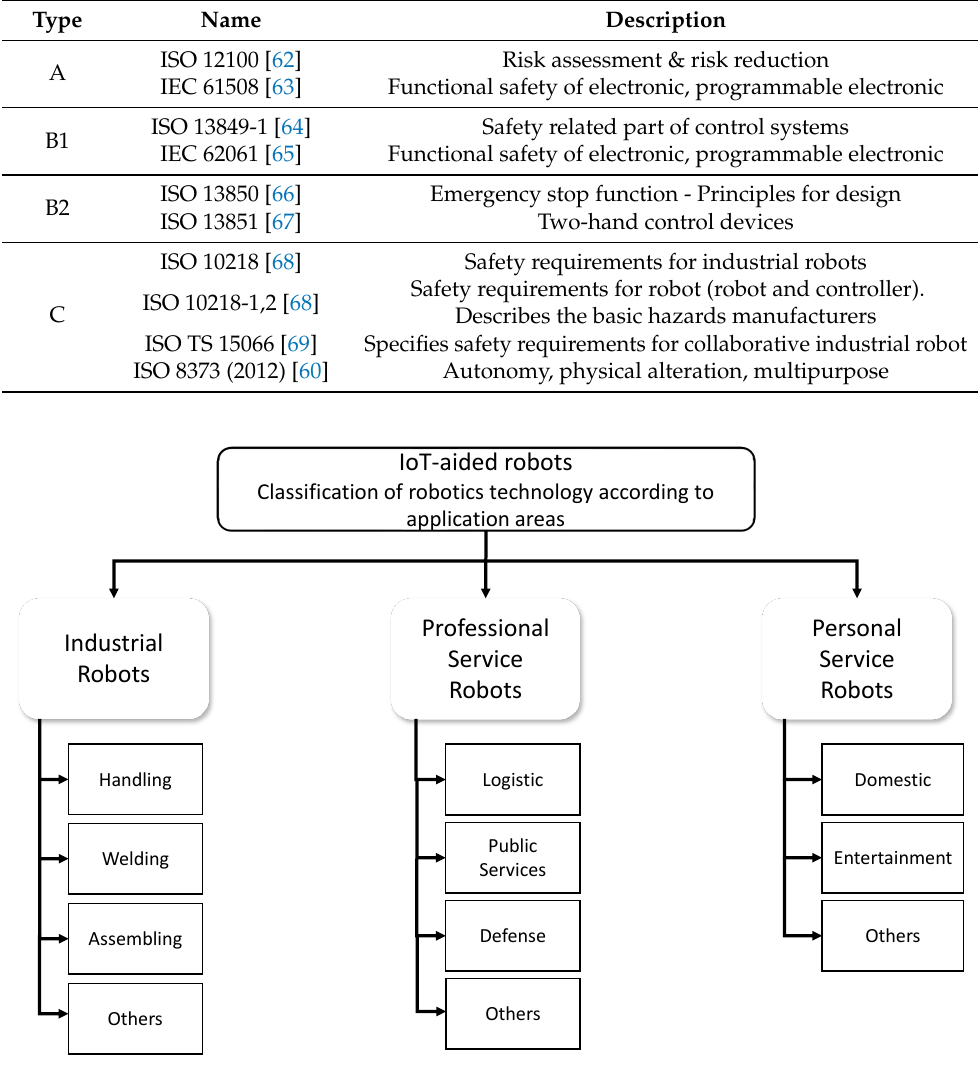
Figure 2. Classification IoT-aided robotic system according to the application areas (top applications are listed